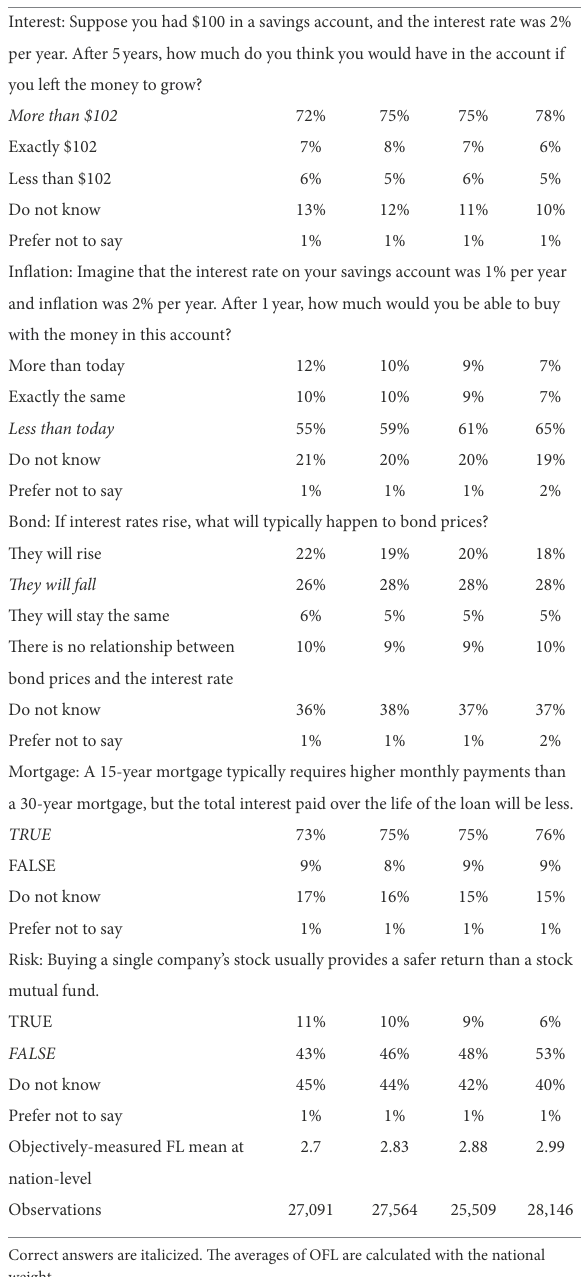
Correct answers are italicized. The averages of OFL are calculated with the national